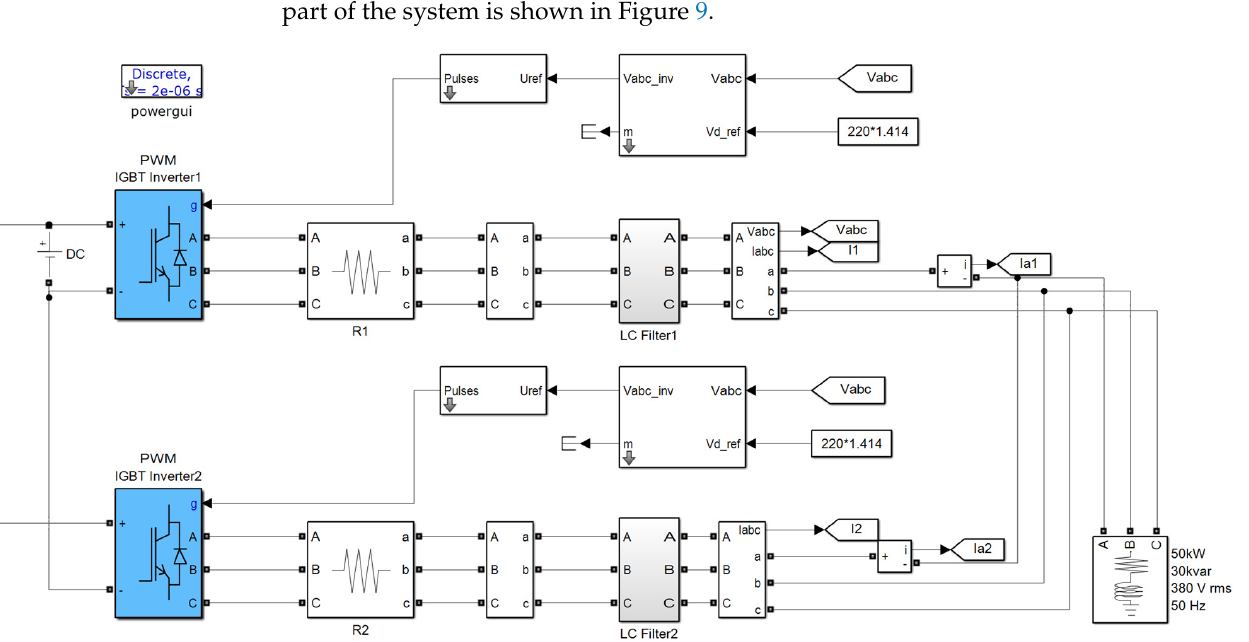
( b ) Figure 10. ( a ) A-phase circulation without current equalization loop. ( b ) A-phase circulation when joining the current equalizing ring. Figure 10b shows the simulation results of the circulating current of the A phase when joining the current sharing loop. It is observed that the circulating current has been significantly suppressed. It is only about 2 A , which only occupies 1.6% of the peak load current of the A phase. The size of the circulation is within the allow able range. In summary, after adding the current sharing loop, the circulating current of the in- verter parallel system can be greatly reduced, which shows the correctness of the current sharing strategy, and further shows that the strategy of using RSC and GSC in parallel to share the rotor overcurrent is feasible.